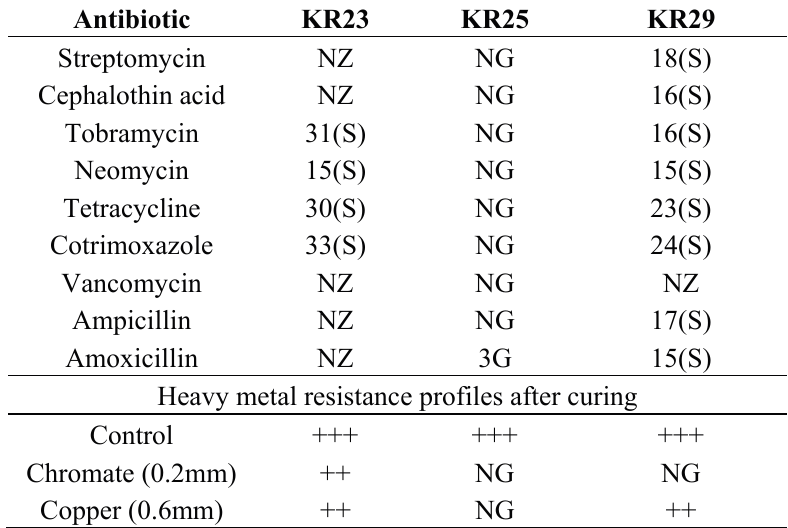
Table 4. Antibiotic and heavy metal resistance profiles of isolates after